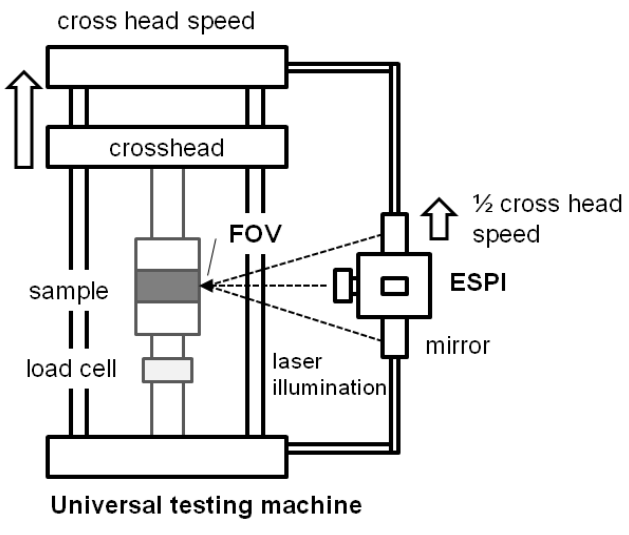
Figure 2. Test setup for internal bond specimen analysis in a testing machine with ESPI test